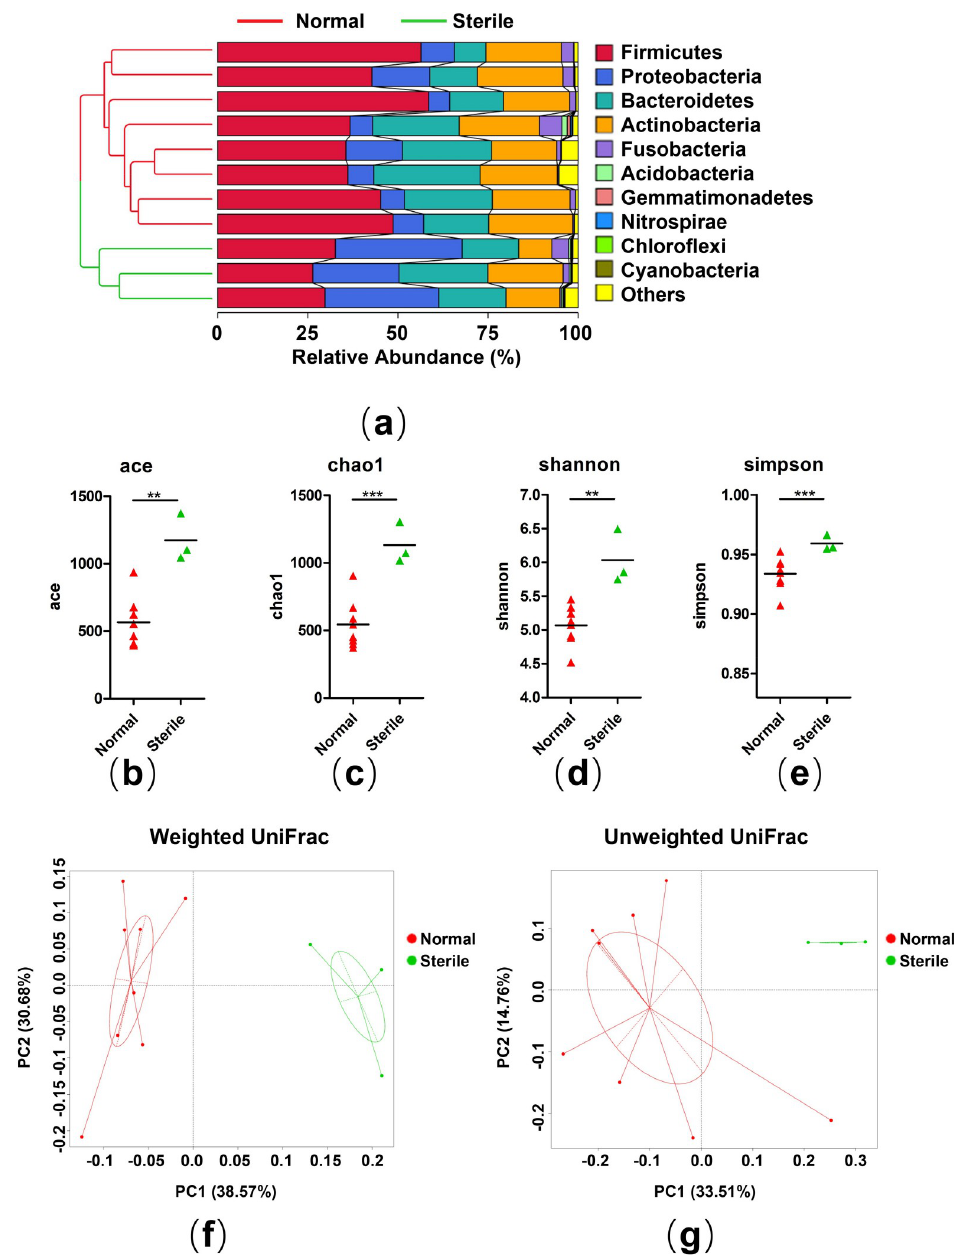
Fig 4. Comparison of gut microbiota between sterile and normal crested ibises. (a) The tree (left) shows the hierarchical clustering of the samples based on Bray-Curtis dissimilarity. The bar chart (right) shows the relative abundance of bacterial phyla in each individuum. The trees have different colors indicating the groups. (b-e) The community richness indicated by Ace (b), Chao1 (c), Shannon (d), and Simpson indices (e). Significance level: �� P < 0.05; ��� P < 0.01. The significance of alpha diversity between groups was evaluated by the Welch’s t-test. (f, g) The beta diversity of bacterial communities was associated with different groups. Principal coordinate analysis (PCoA) was generated using unweighted (f) and weighted (g) Unifrac metrics. The default ellipse was the standard deviation of the group medians.